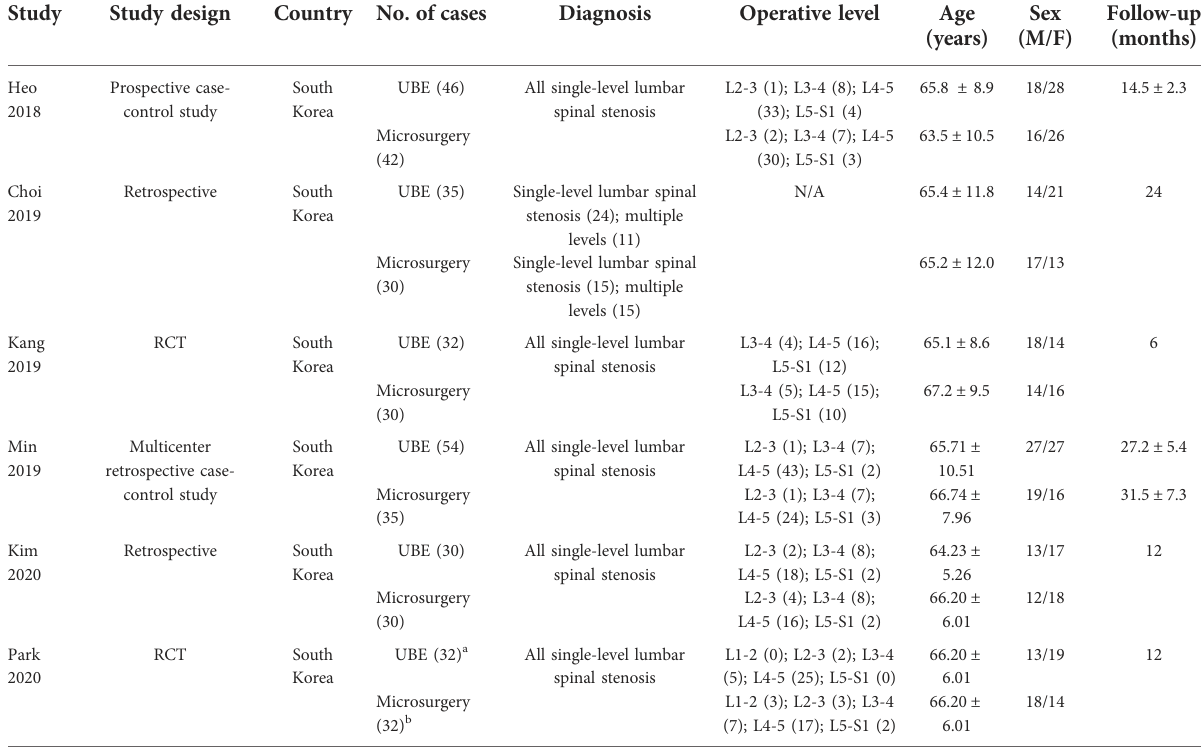
TABLE 2 Characteristics of the included